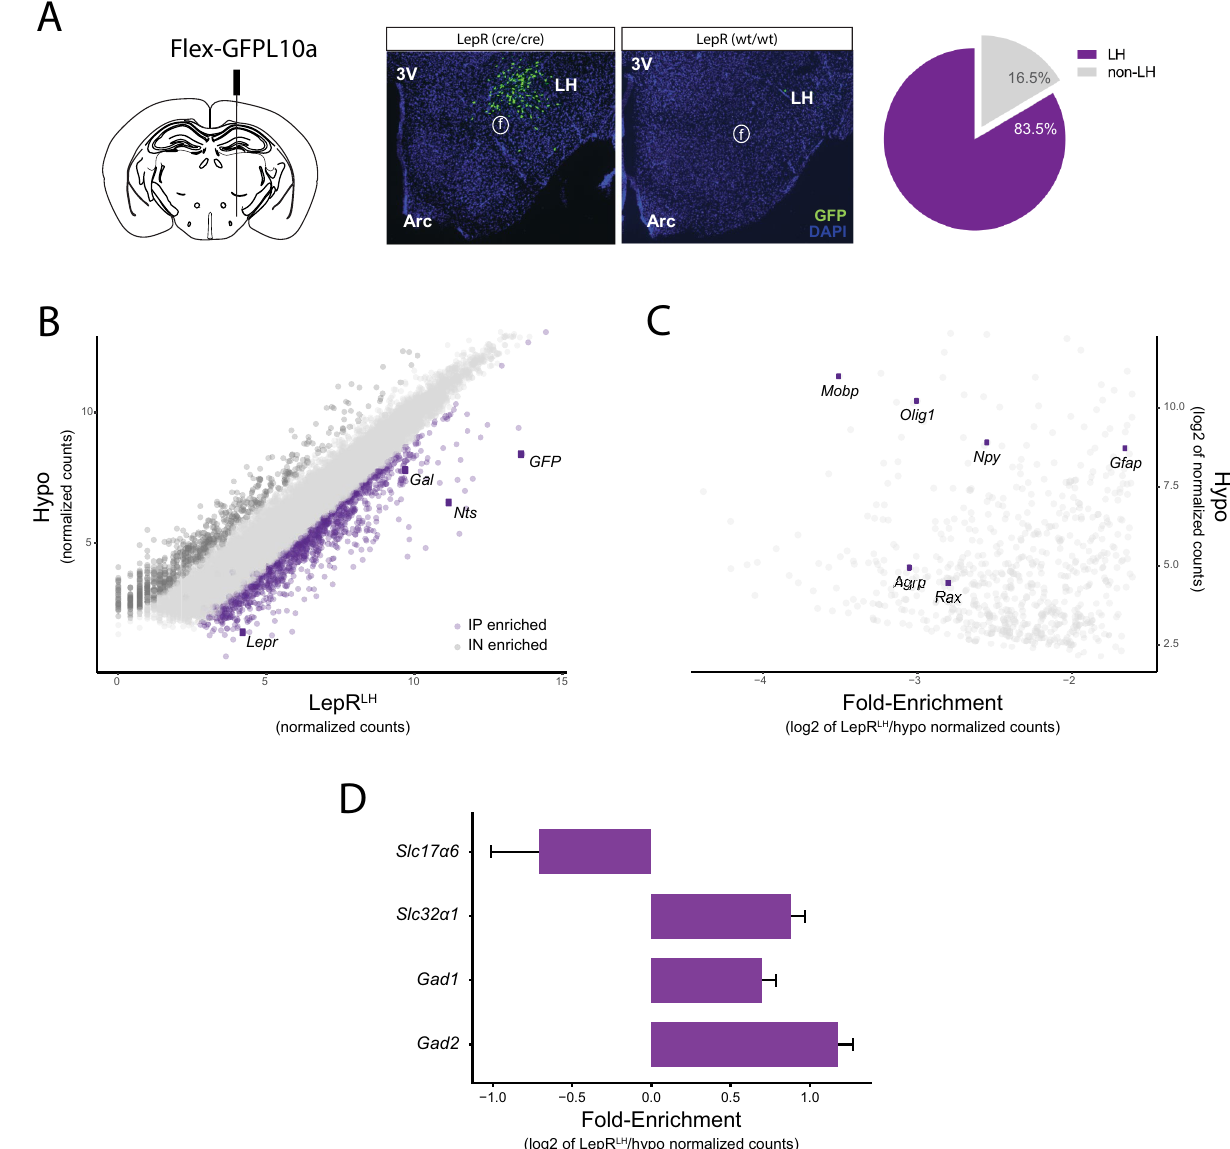
Figure 1. Targeting and RNA enrichment from LepR LH cells ( A ) LepR-Cre mice and wild type mice were injected in the LH with an AAV carrying Flex-L10:GFP (graphic of coronal section does not represent exact coordinates). In wild-type littermates (wt/wt) the GFP expression was very low (right image) compared to LepR-cre mice. In homozygous Cre (cre/cre) mice, 83.5% of the cells with immunohistochemically-detected GFP were in the LH (mean, n = 12 hypothalami). ( B ) Scatterplot of RNAseq results showing normalized counts from LepR LH fraction (IP) in x axis plotted against normalized counts from Hypothalamus fraction (IN) in y axis. Violet-colored dots represent genes that are enriched in IP (with log2FoldChange > 1.5 and adjusted p < 0.01) and dark grey-colored dots represent genes that are enriched in IN (with log2FoldChange < − 1.5 and adjusted p < 0.01). GFP, LepR and known marker genes of LepR LH cells are represented as dots colored in dark violet. ( C ) Scatterplot of RNAseq results showing genes de-enriched in IP fraction (enriched in IN fraction) as log2 of normalized counts from IN fraction (x-axis) plotted against Fold-enrichment (log2 of IP/ IN normalized counts) (y-axis). Markers known to not be present in LepR LH cells ( Agrp , Npy ) and non-neuronal markers are represented as dark violet dots. ( D ) Barplot showing Fold-enrichment (log2 of IP/IN normalized counts) of GABAergic markers Slc32a1 , Gad1 and Gad2 and glutamatergic marker Slc17a6 (mean ± SEM). IP: immunoprecipitated samples, IN: input